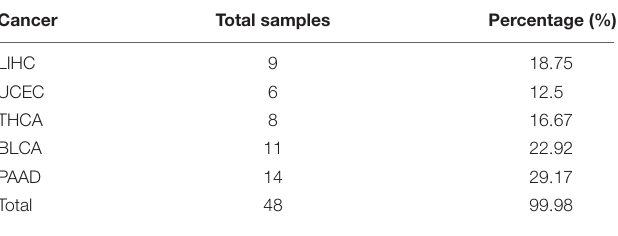
TABLE 2 | Detailed information of data covering five cancers downloaded from